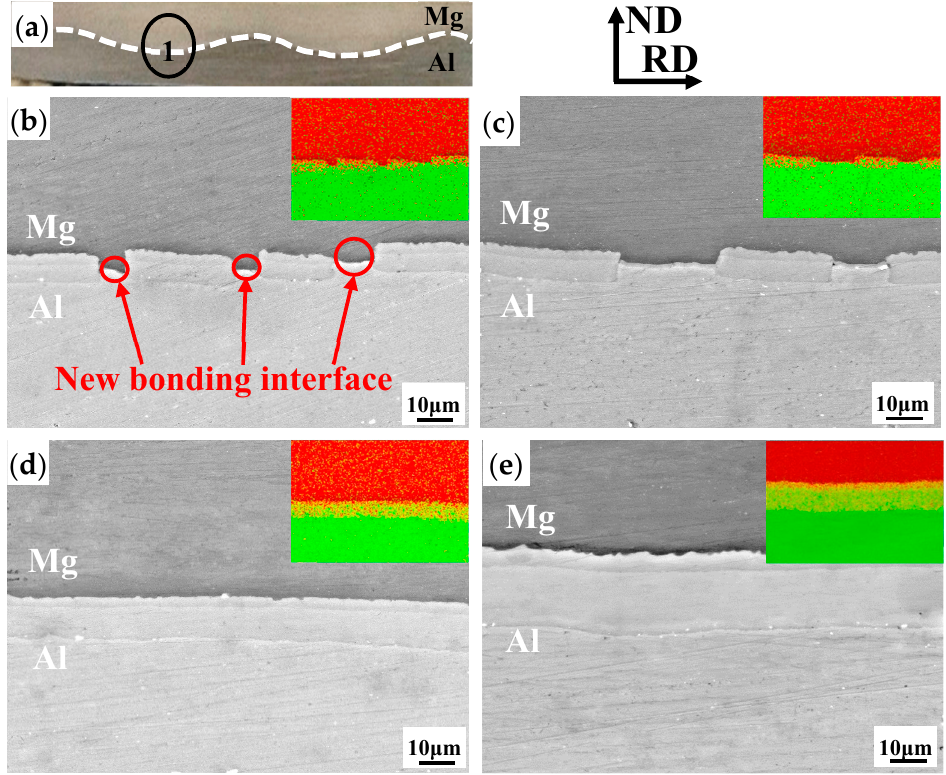
Figure 7. SEM images and elemental scanning distribution of CFR flattened samples along RD: ( a ) Selected location schematic; ( b ) as-rolled; ( c ) 200 °C; ( d ) 300 °C; and ( e ) 350 °C.